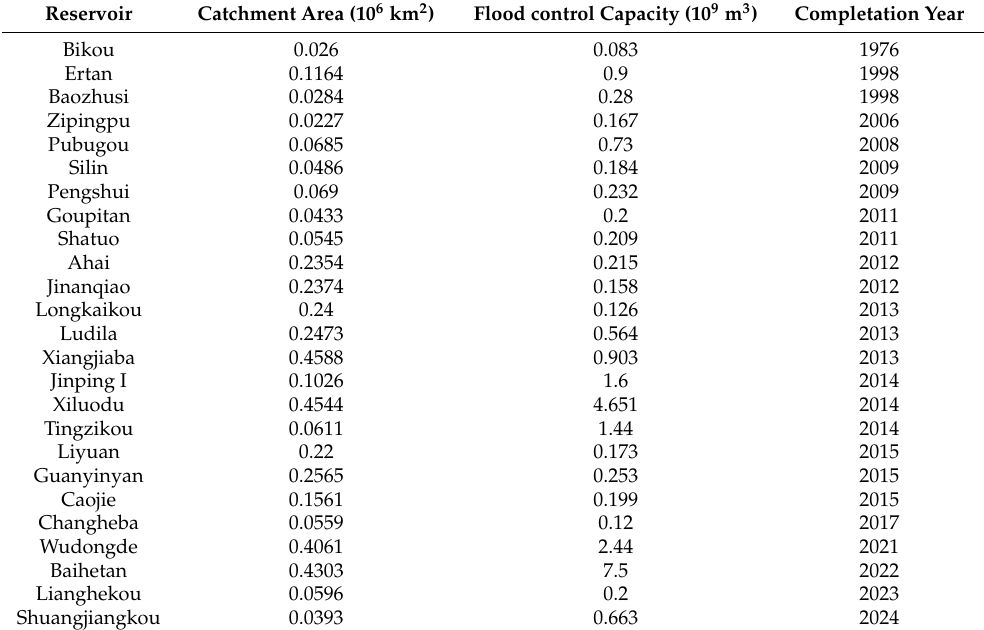
Table 1. Information on the reservoirs upstream the Three Gorges